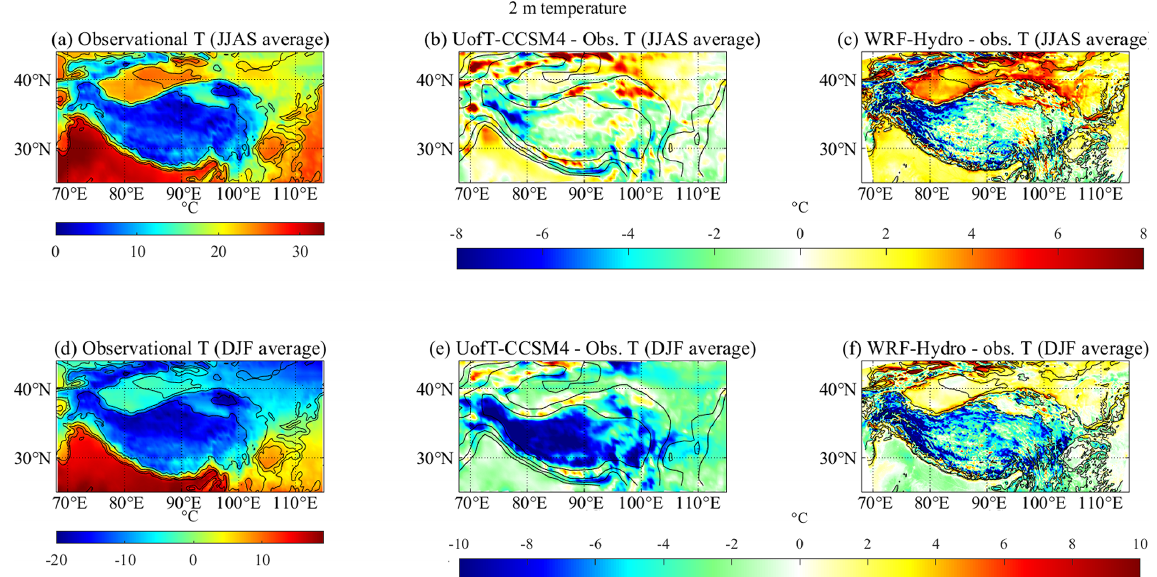
Figure 2. Absolute 2m air temperature bias with respect to (a, d) the CRU observational dataset of (b, e) UofT-CCSM4 and (c, f) the WRF ensemble in (a–c) JJAS and (d–f) DJF. The topography contours of 500, 1000, 2000, and 4000m are also shown in